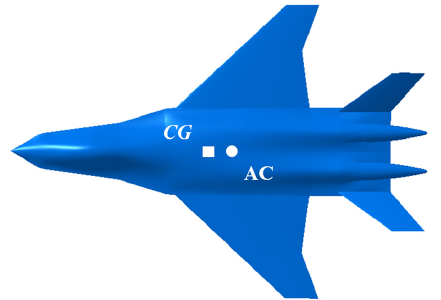
Figure 7. CG and AC positions of the aircraft.